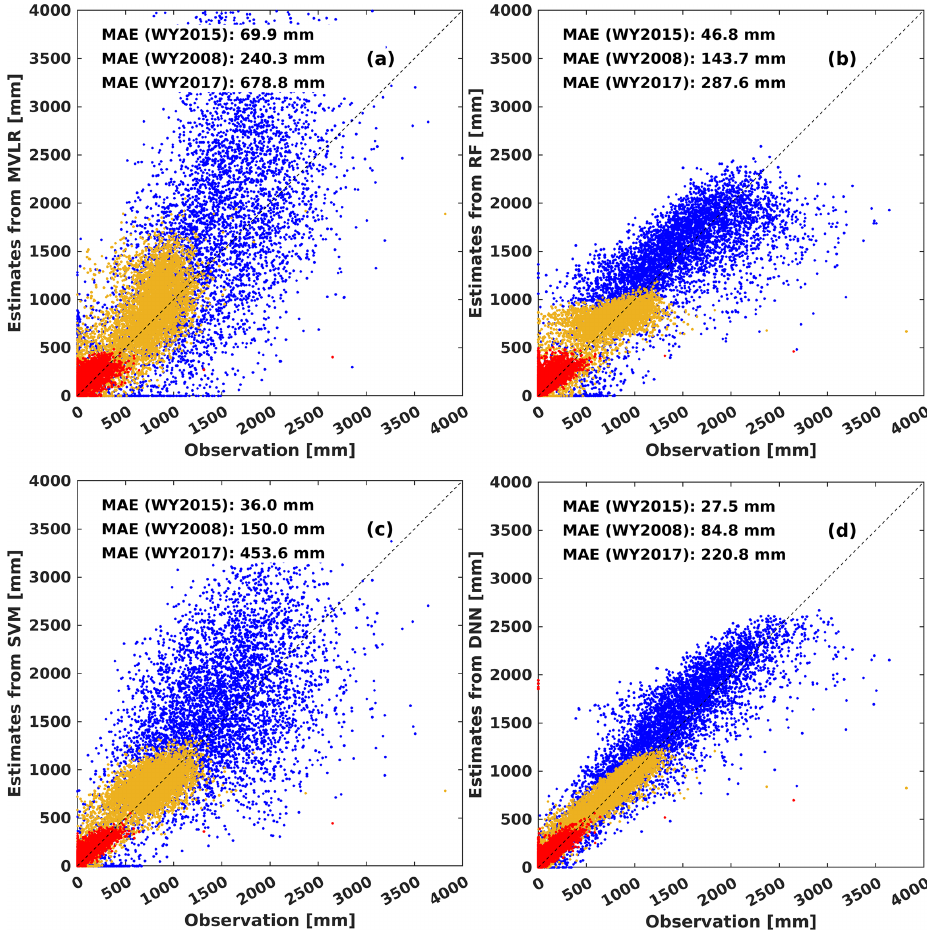
Figure 2. Pixel-level scatterplots of 1 April SWE estimated by MVLR (a) , RF (b) , SVM (c) , and DNN (d) versus the true 1 April SWE in WY2015 (dry year; red dots), WY2008 (normal year; yellow dots), and WY2017 (wet year; blue